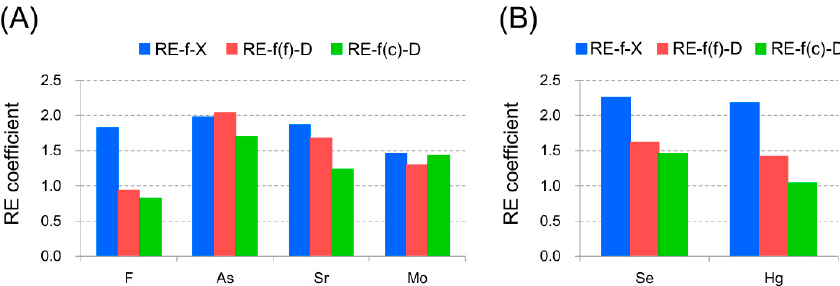
Figure 10. Average relative enrichment (RE) coefficient of elements (( A ), * f/b > 2.5; ( B ), * f/b ≫ 2.5) in the fly ashes from Xilaifeng (X) and Damo (D).